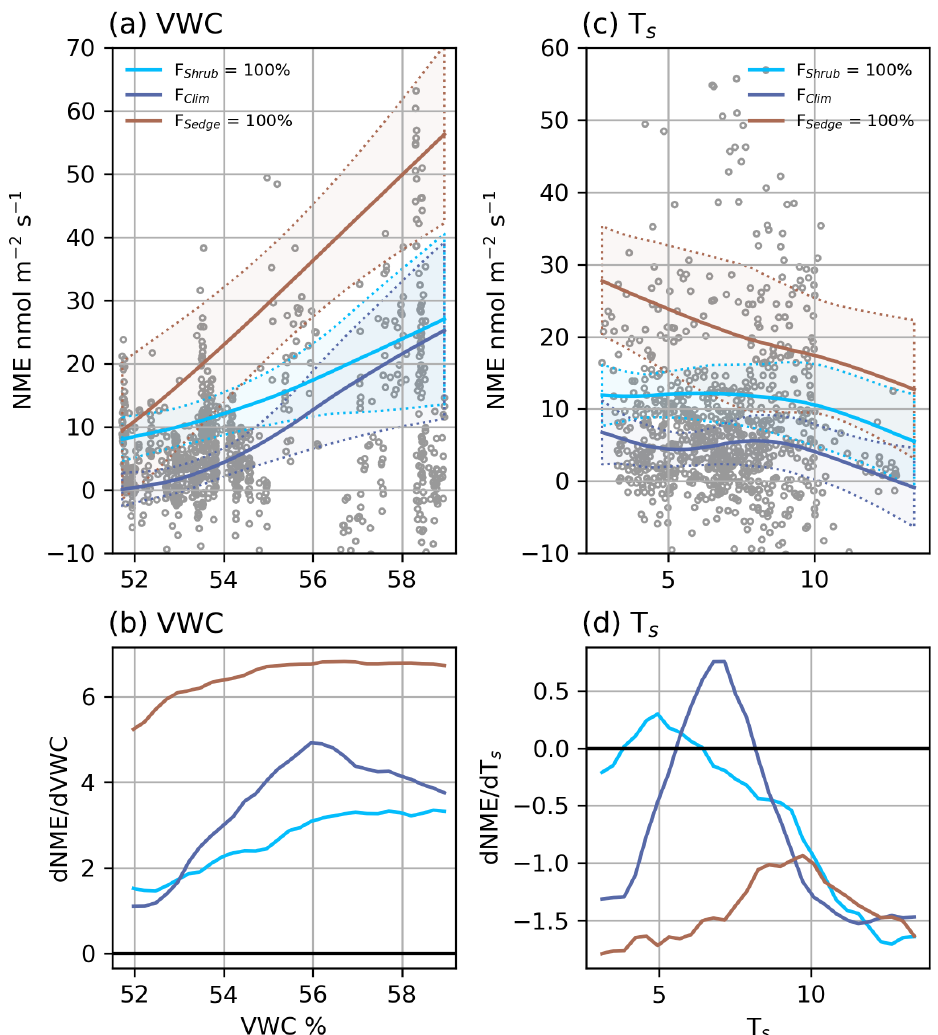
Figure 5. (a) Modelled NME response to VWC at different source area fractions and (b) the partial first derivatives of NME with respect to VWC. (c) Modelled NME response to T s at different source area fractions and (d) the partial first derivatives of NME with respect to T s . The shaded areas in (a) and (c) are 95% confidence intervals and grey circles are the EC